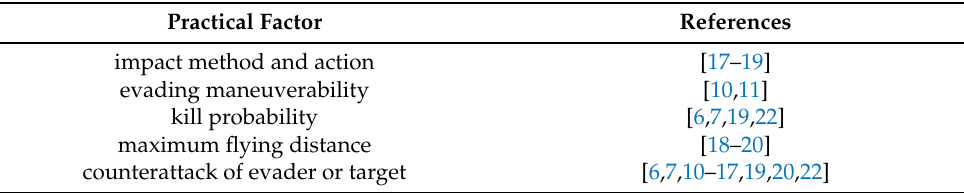
Table 1. Suggested practical factors for relevant works in Section